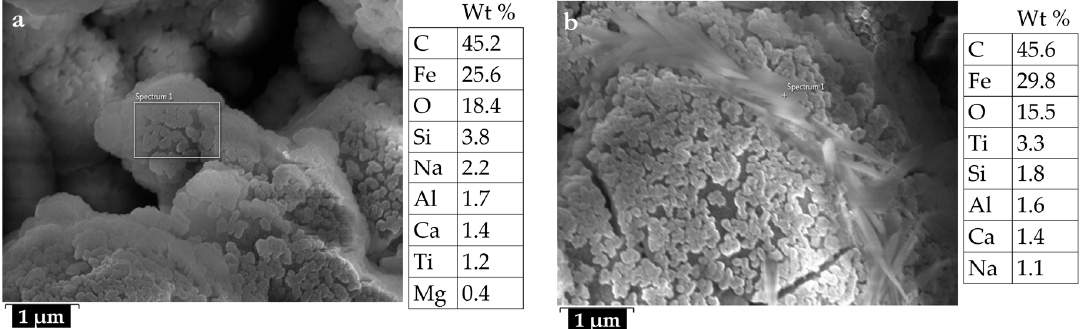
Figure 8. EDX analysis on the region of interest for ( a ) magnetite and ( b ) hematite in the SO-CFA sample.